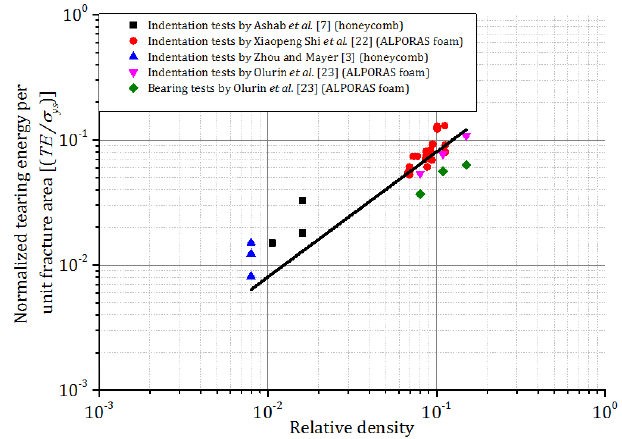
Figure 7. Normalized tearing energy per unit fracture area vs. relative density of different cellular materials.